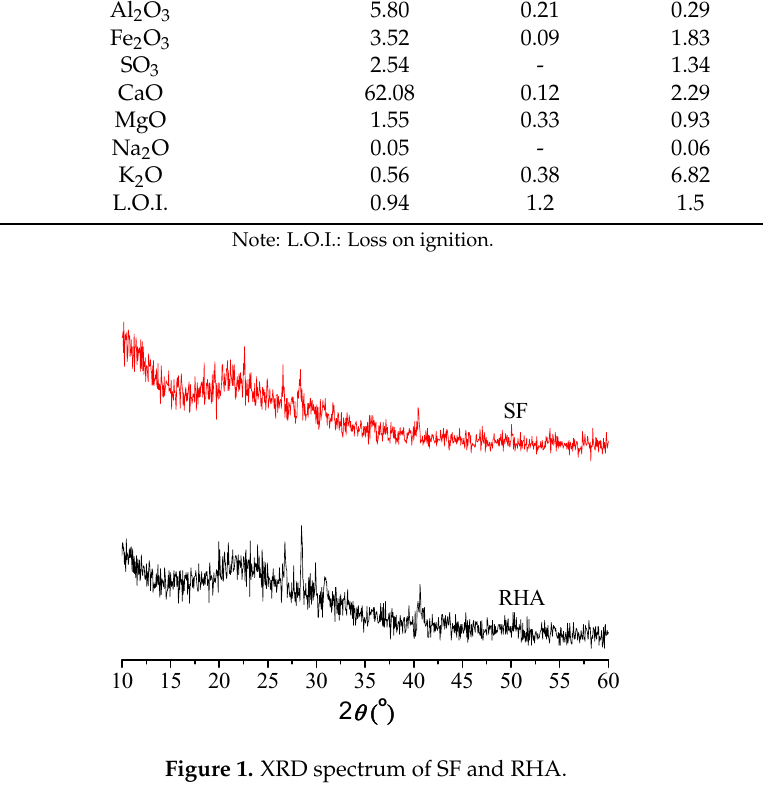
Table 3. Physical properties of cement, SF, CRHA, and FRHA.